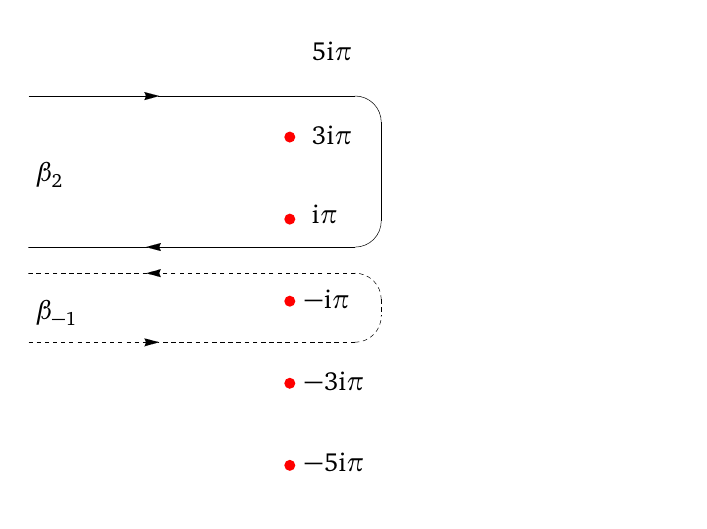
Figure 20: Paths β (solid curve) and β − (dashed curve) from −∞ to −∞ in (cid:67) . 2 1 ε > 0, ε → 0, the path of integration can be split into a path from −∞ to 2i π n − ε with Re v < 0 plus a path from 2i π n + ε to ν with Re v > 0. The translation identities (67) for χ